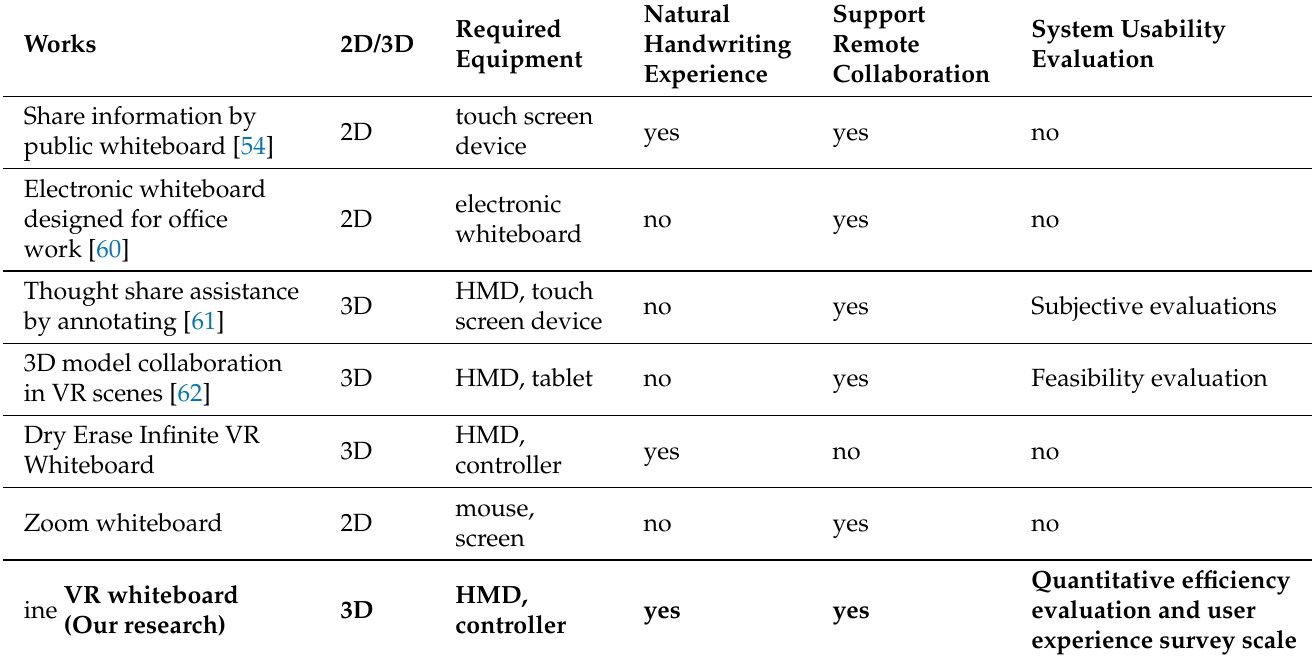
Table 1. Related research on whiteboards in terms of “Required equipment”, “Natural handwriting experience”, “Support remote collaboration” and “System usability